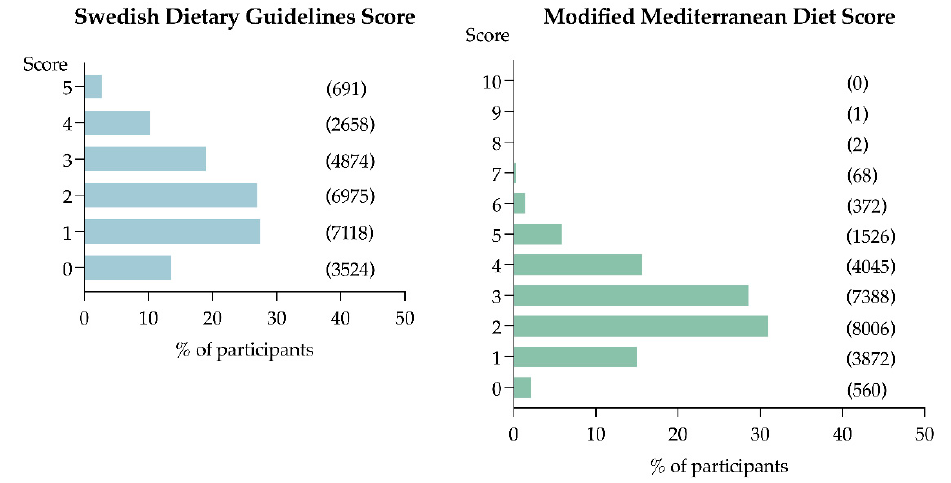
Figure 2. Percentage of participants according to score punctuation. Number of participants classified on their score punctuation presented in parentheses.